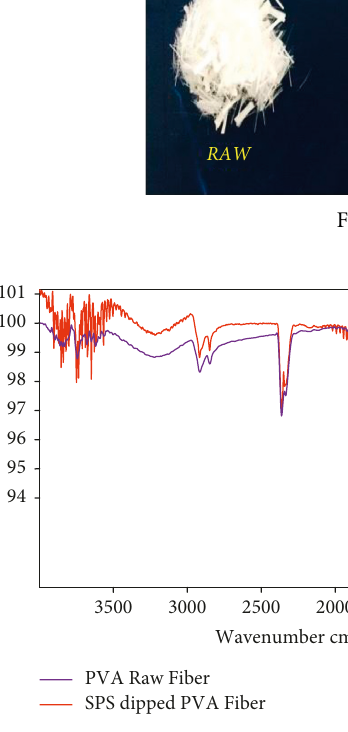
Figure 2: FTIR analysis of raw and SPS-dipped PVA